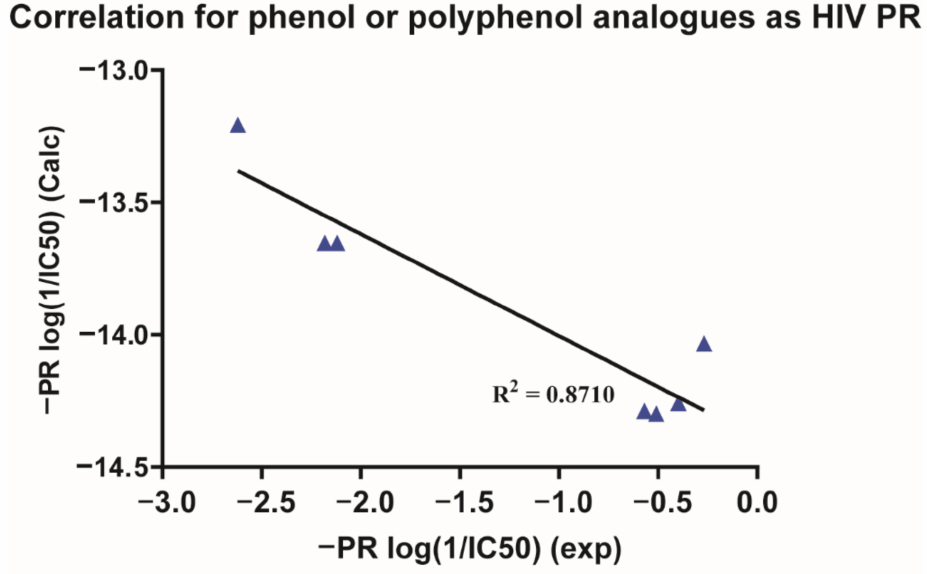
Figure 6. Strong correlation of docked phenol or polyphenol analogs supports a common mode of binding for HIV